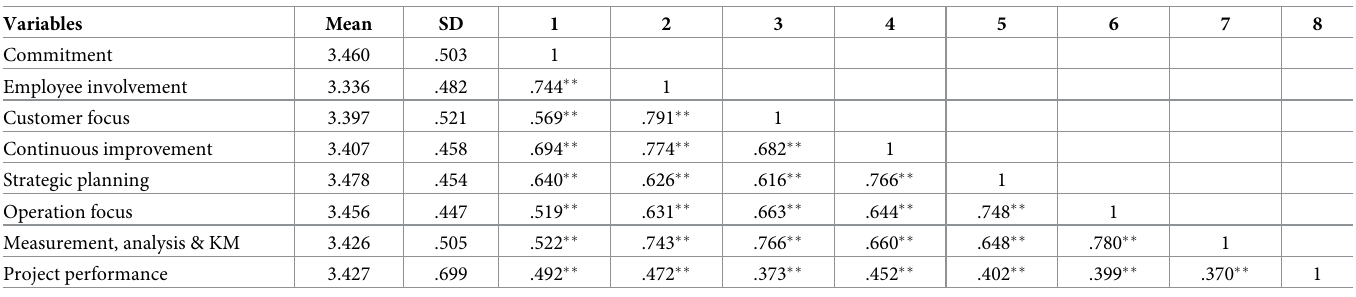
Table 3. Descriptive and